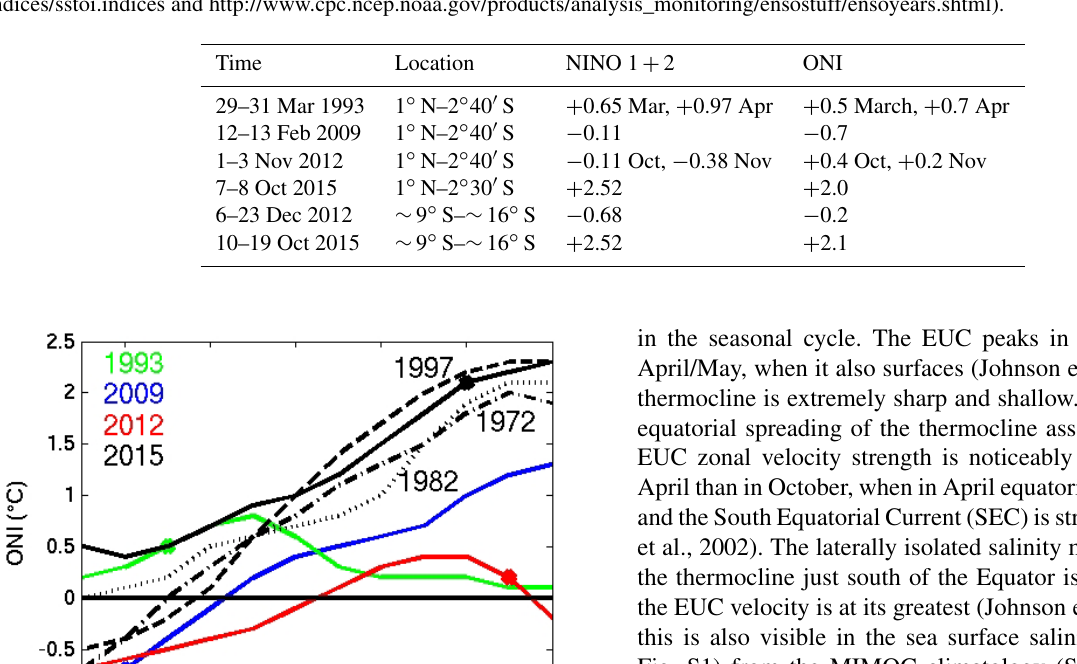
Table 1. Time and geographical location of CTD data used in this study and the NINO 1 + 2 and ONI indices for the months of observation or for 2 months for measurements carried out at the end or beginning of a month listed in the tables (http://www.cpc.ncep.noaa.gov/data/ indices/sstoi.indices and http://www.cpc.ncep.noaa.gov/products/analysis_monitoring/ensostuff/ensoyears.shtml).